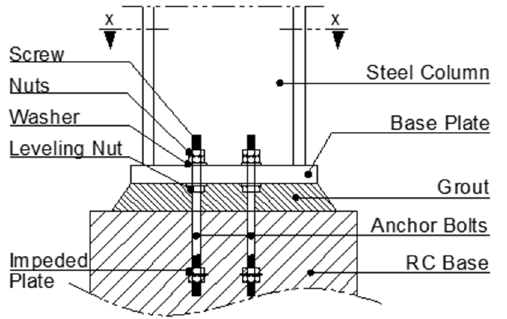
Figure 1. The traditional shape of pinned base connection.